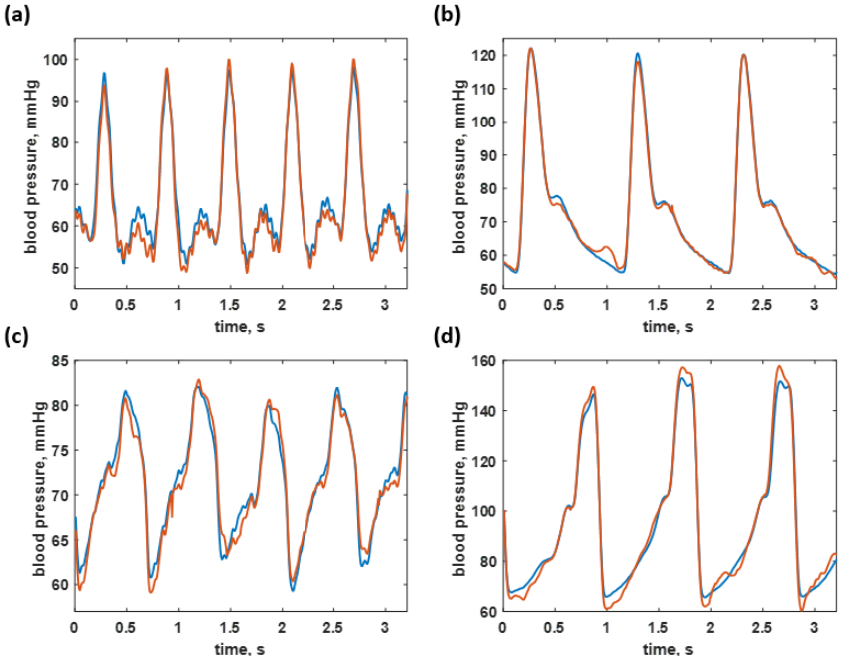
Figure 9. Shows the blood pressure predicted by the trained neural network (red curves) compared to the actual blood pressure signal (blue curves) across four ranges: ( a ) 108/55 mmHg (healthy); ( b ) 125/60 mmHg (healthy); ( c ) 79/58 mmHg (hypotension); and ( d ) 150/67 mmHg (hypertension).